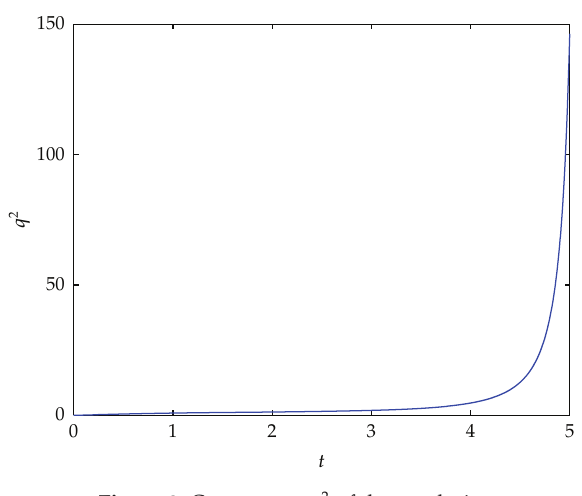
Figure 3: Component q 2 of the geodesic.